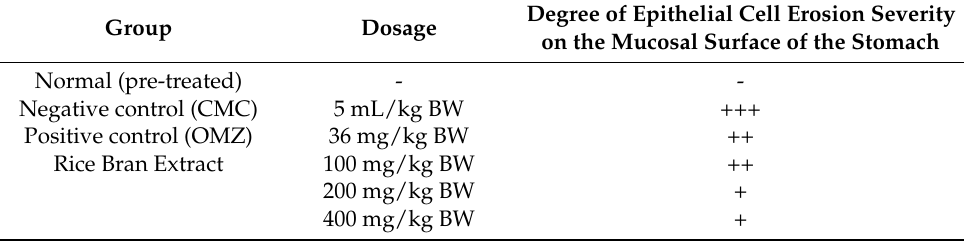
Table 4. An overview of the histopathology of epithelial cells on the surface of the gastric mucosa of rats in the treatment group induced by ethanol. Degree of Epithelial Cell Erosion Severity Group Dosage on the Mucosal Surface of the Stomach Normal (pre-treated) - - Negative control (CMC) 5 mL/kg BW +++ Positive control (OMZ)